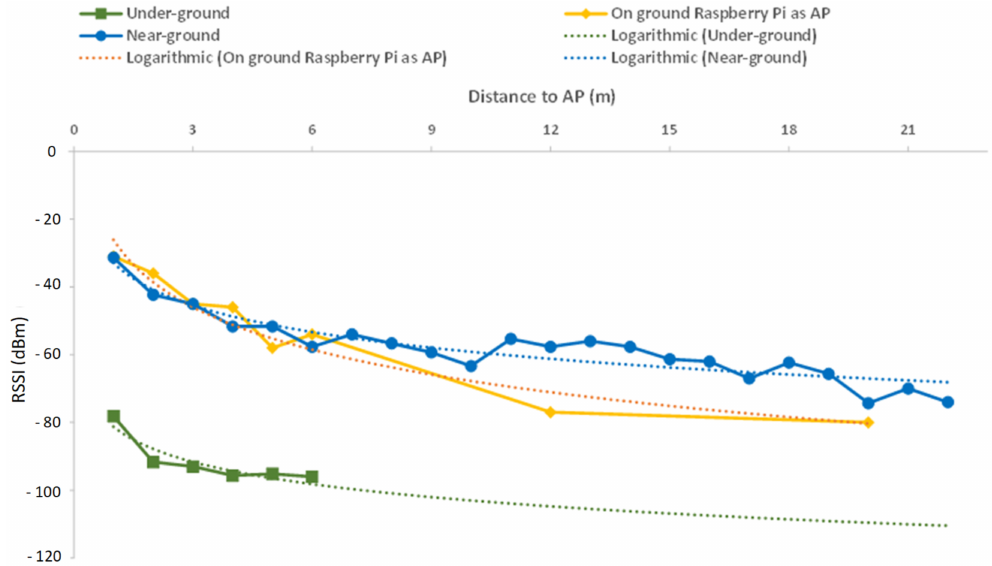
Figure 19. Comparison of network coverages with measured data using a Raspberry Pi as AP.